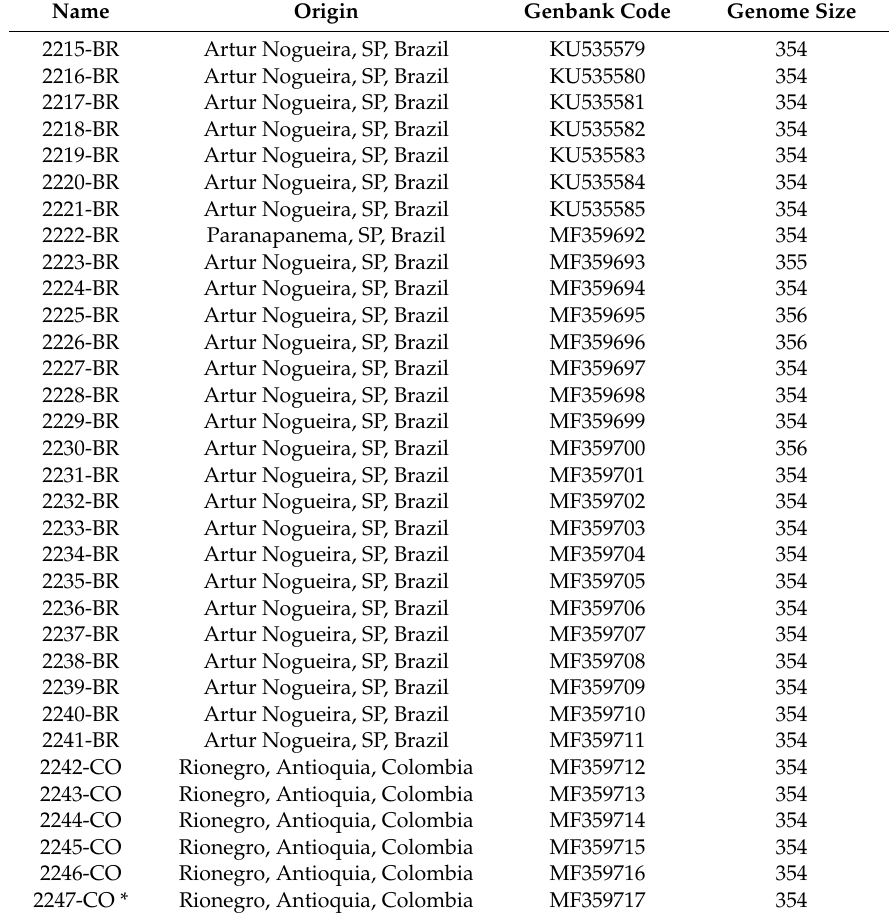
Table 2. Sequence variants of chrysanthemum stunt viroid (CSVd) collected in two regions in the State of S ã o Paulo, Brazil, and in the region of Rionegro, Antioquia, Colombia, with the access code in the Genbank and genome